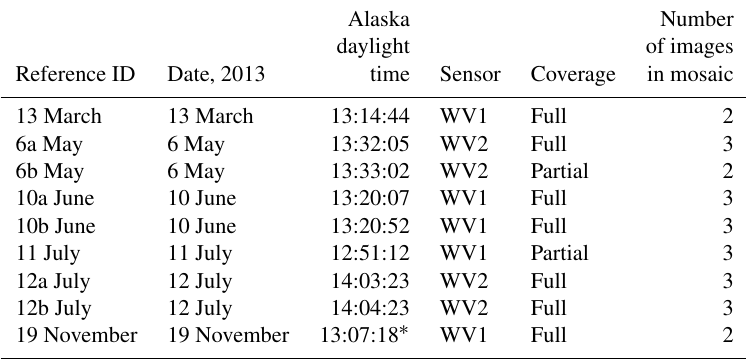
Table 1. Survey of images used in this study. Image processing was performed by the Polar Geospatial Center prior to our obtaining the images. Satellites used were WorldView 1 and 2 (WV1, WV2). Projection is NAD83.